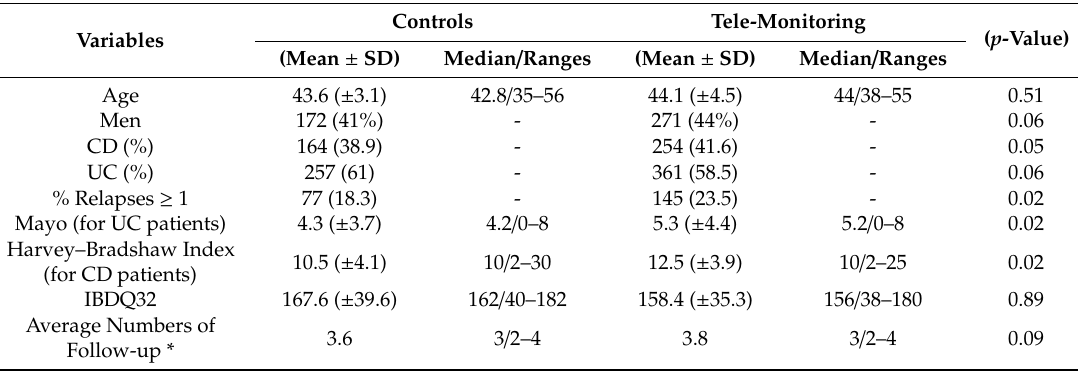
Table 1. Summary of patients’ characteristics by group: control and tele-monitoring groups.